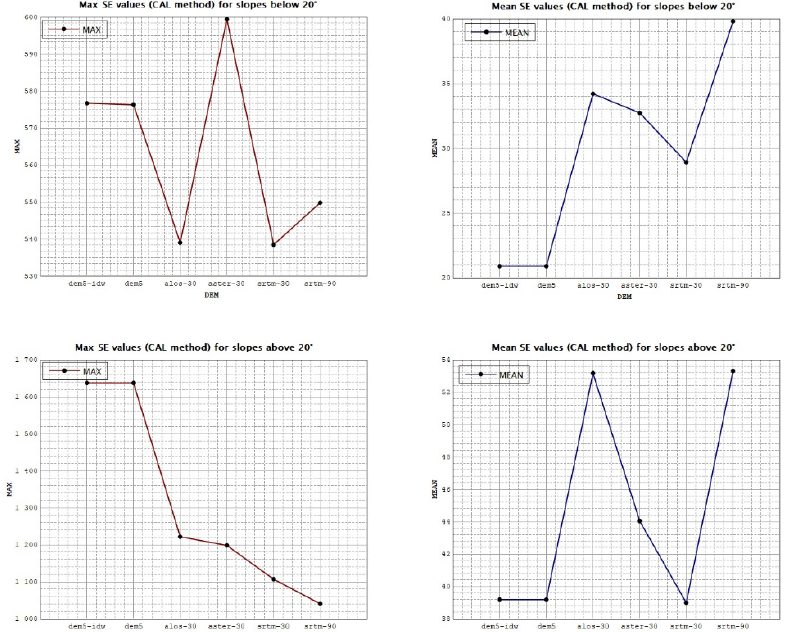
Figure 14. Maximum and mean values of SE for slopes below and above 20° (CAL method).